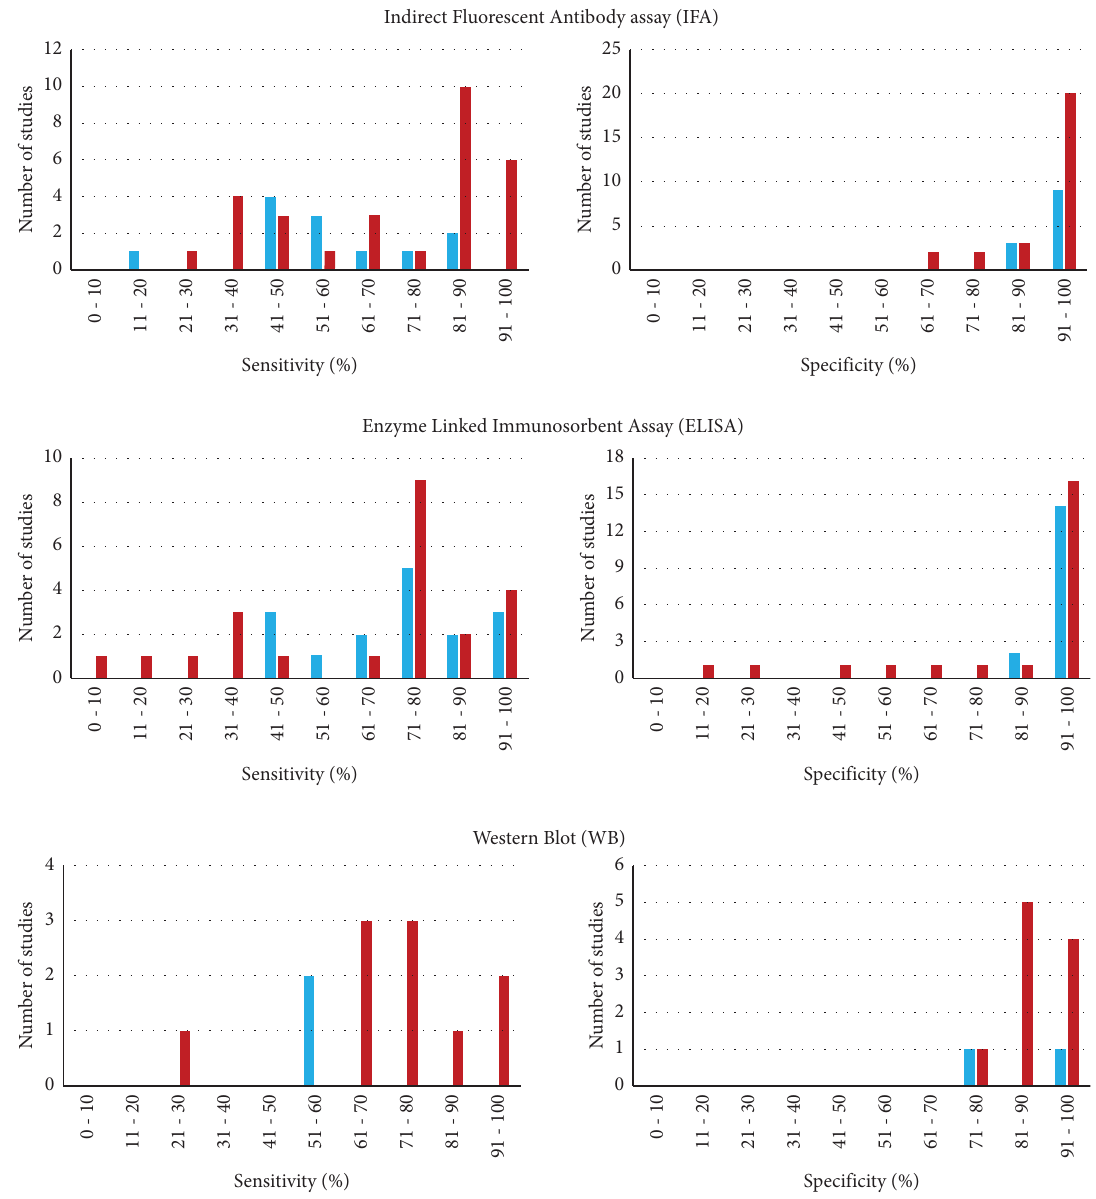
Figure 4: Sensitivities and specifcities of serological assays provided by studies from 1950 to 2022. Red color indicates sensitivities and specifcities of IgG antibody assays, and blue color indicates IgM antibody assays. Left column represents the sensitivities of the included studies, and right column represents the